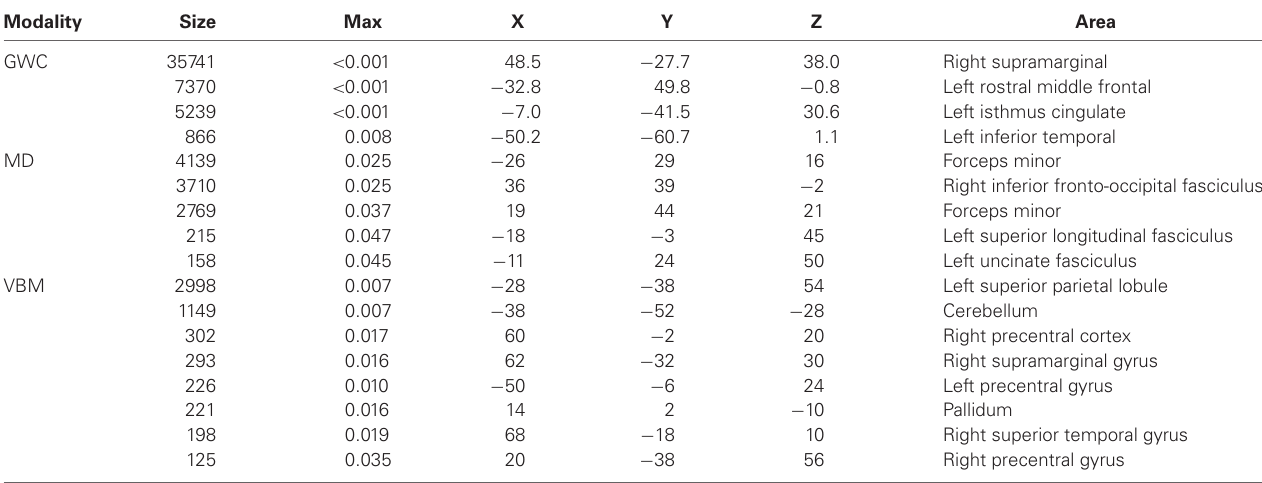
Table 4 | Clusters ( > 100 voxels) showing relationship between GWC MD and VBM brain regions and mPFC-PCU connectivity measures